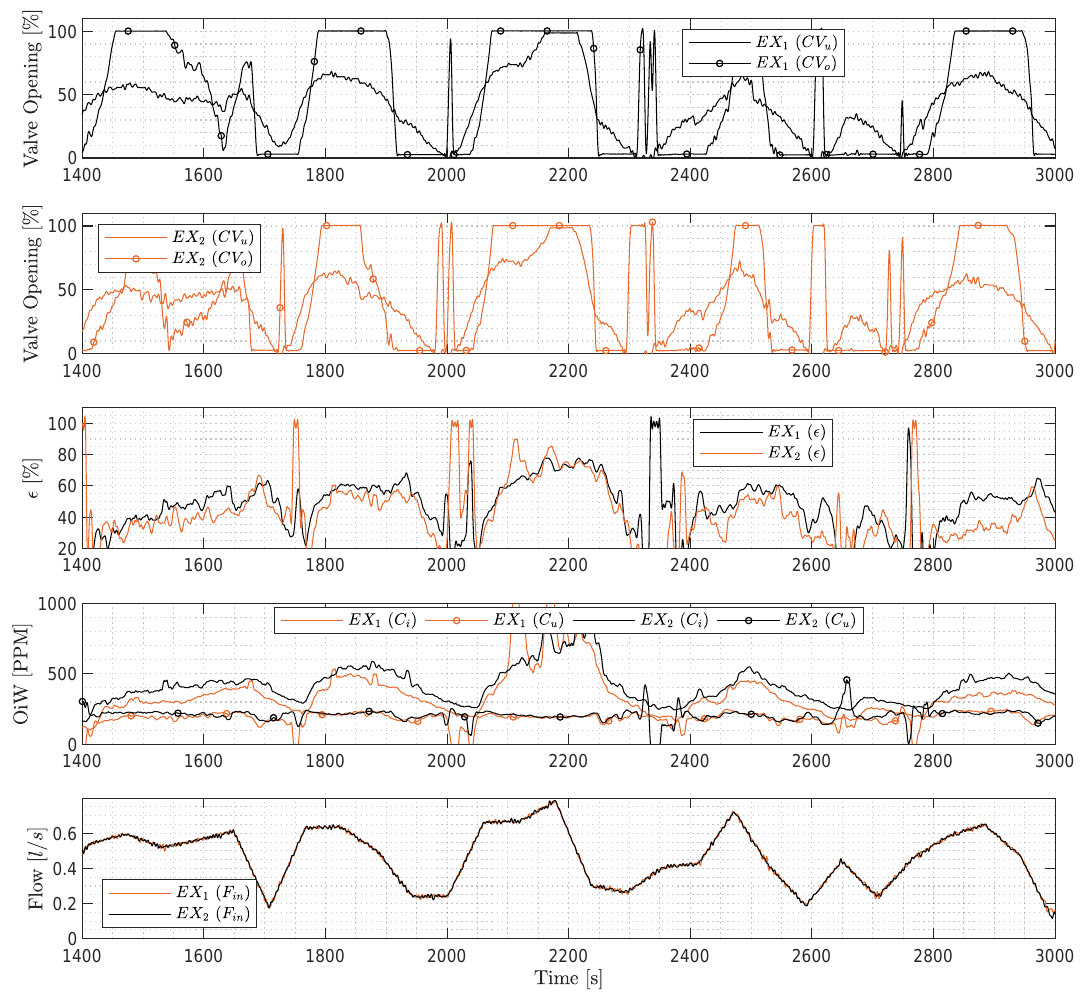
Figure 2. Experiment Results: Dynamic-Tracking Capability analysis; results of two experiments EX 1 and EX 2 performed under the same operating conditions using the same PID control solution; the plots show valve openings, efficiencies, OiW concentrations, and F in